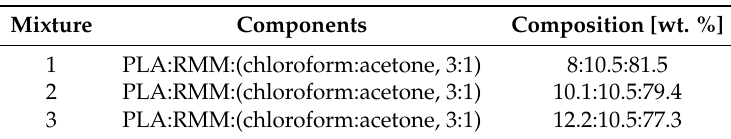
Figure 3. IR spectra of ( a ) pure PVP (black); M (red); CL (blue) and LCE-PVP fibers polymerized at 55 ◦ C (green continuous) and ( b ) pure PLA (black); M (red); CL (blue); LCE-PLA fibers polymerized at 55 ◦ C (green continuous) and CL-PLA fibers polymerized at room temperature (green dashed). The dashed line highlight the regimes of the C=C stretch (1635 cm − 1 ) and C=H bend (810 cm − 1 ) vibrations, respectively. Table 1. Composition of PLA and RMM